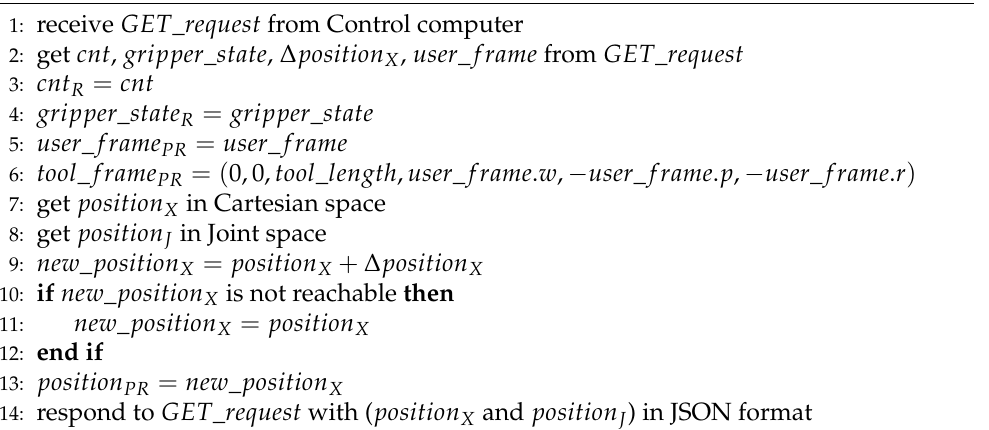
Algorithm 3 Collaborative robot: Register update based on received request.